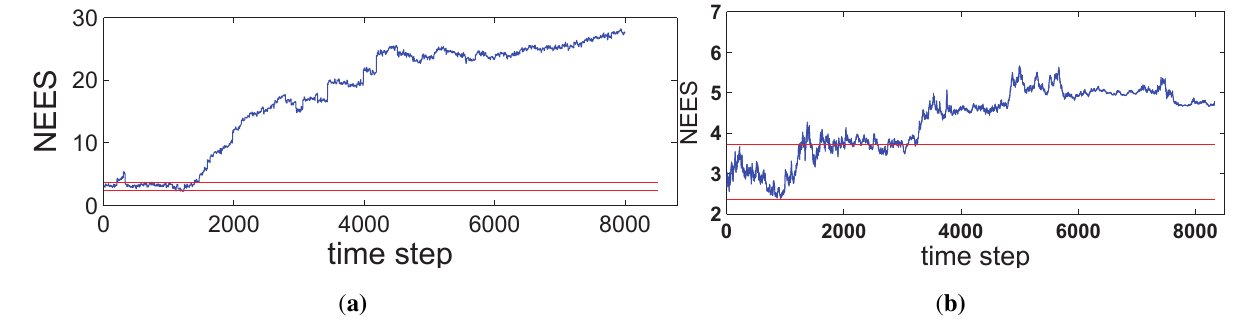
Figure 6. Average normalized estimation error square (NEES) of SEIF ( a ) and ISEIF ( b